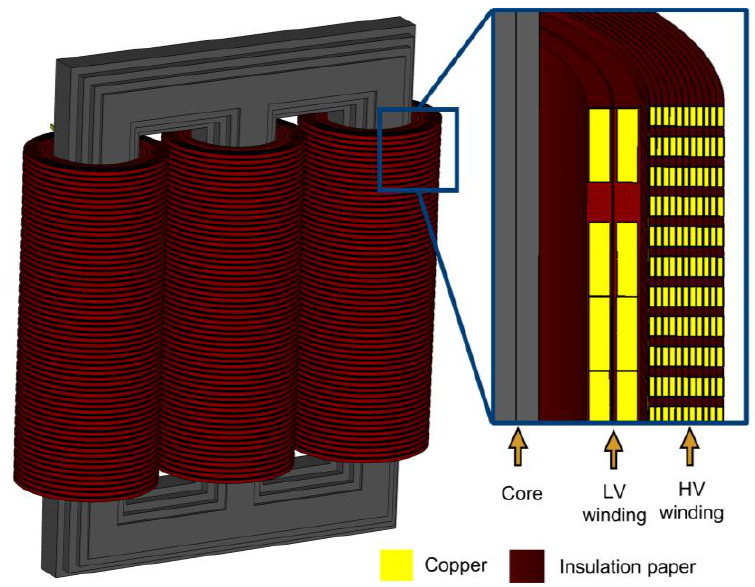
Figure 4. Three-dimensional geometry of a three-phase transformer in CST Microwave Studio.